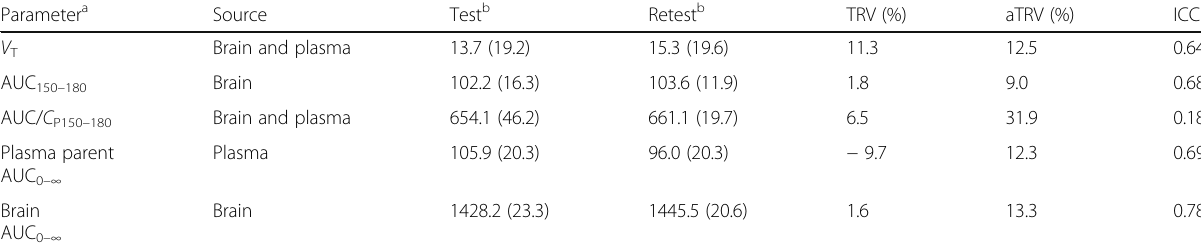
Table 3 Variability and reliability of test-retest parameters from 10 healthy volunteers after injection of [ 18 F]LSN3316612 Parameter a